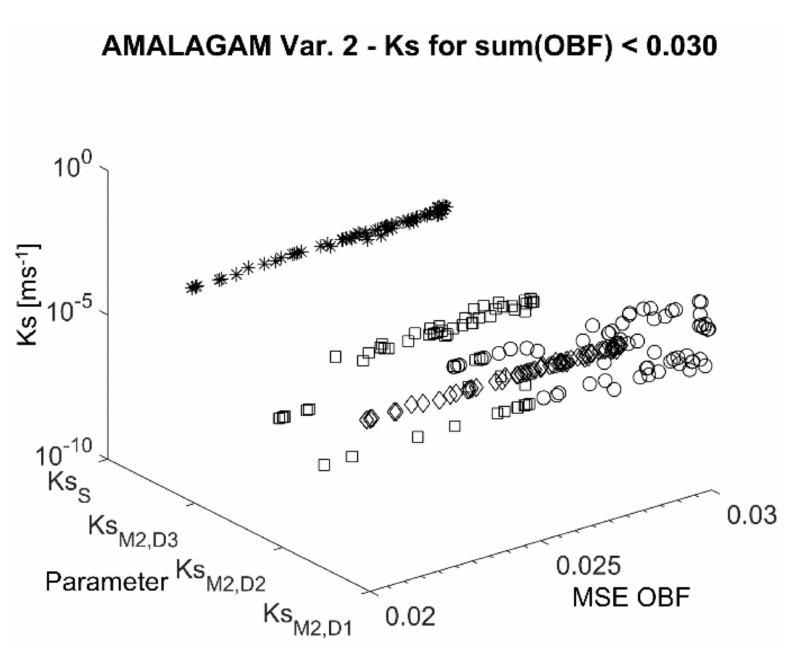
Figure 13. Pareto combinations of the Ks value obtained by the AMALGAM approximation for Var. 2.